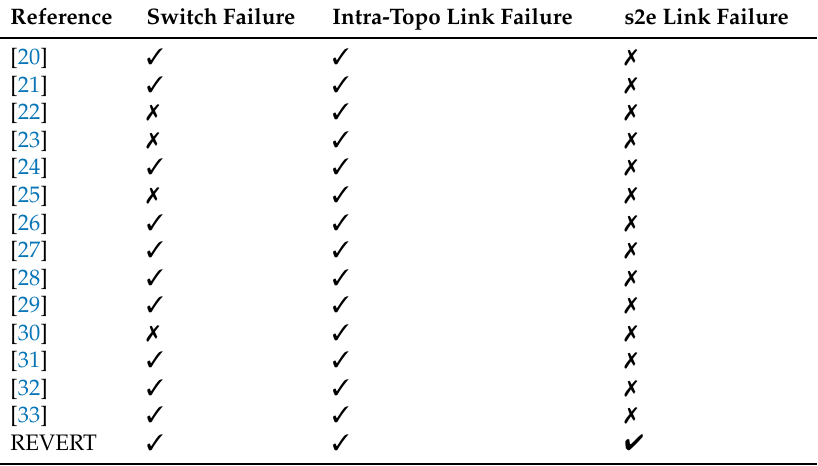
Table 3. Comparison of ability of recovering three kinds of failures.